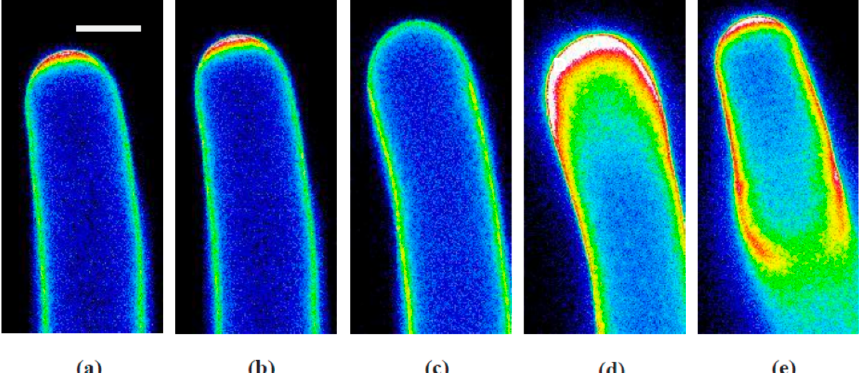
Figure 8. Changes in PI fluorescence at the pollen tube tip corresponding to growth rate changes caused by a transient exposure to 200 µM KCN: ( a ) oscillatory growth before KCN treatment, minimum PI signal at the tip; ( b ) oscillatory growth before KCN treatment, maximum PI signal at the tip; ( c ) minimum tip PI signal just prior to maximal growth inhibition; ( d ) large accumulation of PI-reactive material during maximal growth inhibition; ( e ) return of oscillatory growth pattern. Bar in panel ( a ) corresponds to 10 µm.